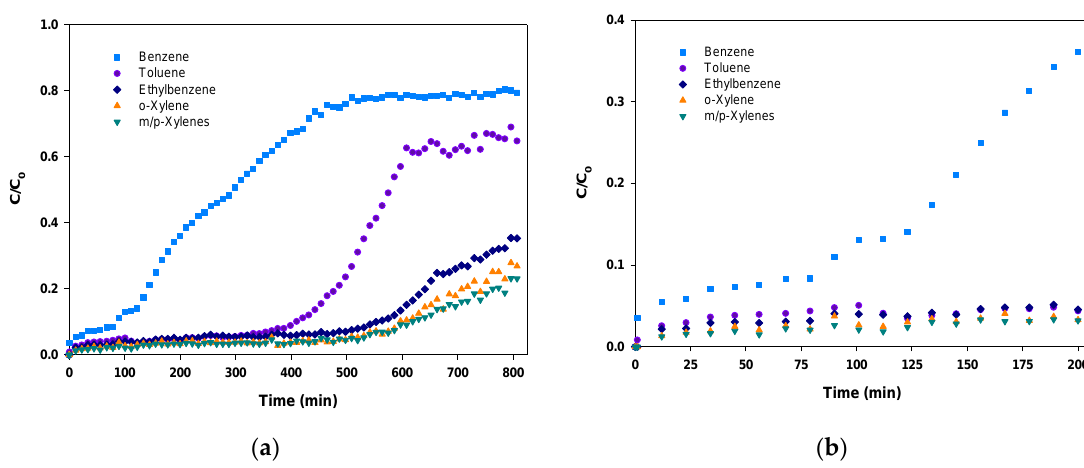
Figure 5. ( a ) C/C 0 vs. time during a breakthrough experiment performed with an equimolar 1 ppm mixture of BTEX over Basolite-filled preconcentrator and ( b ) enlarged view of the first 200 min of the experiment.